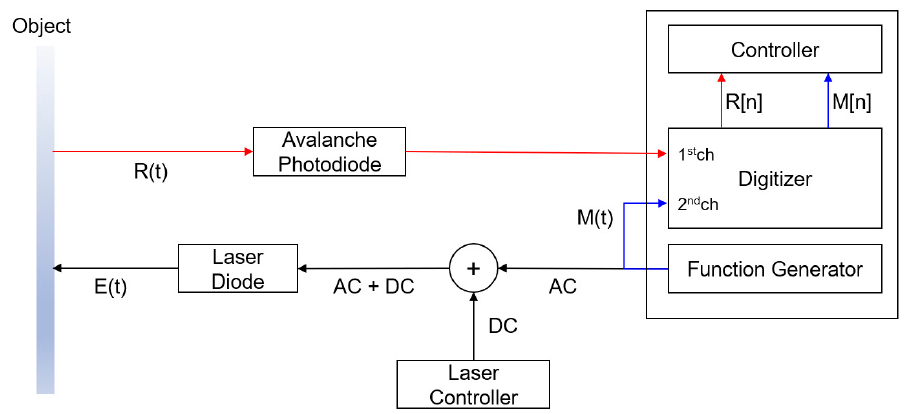
Figure 6. Signal flows of the measurement system.